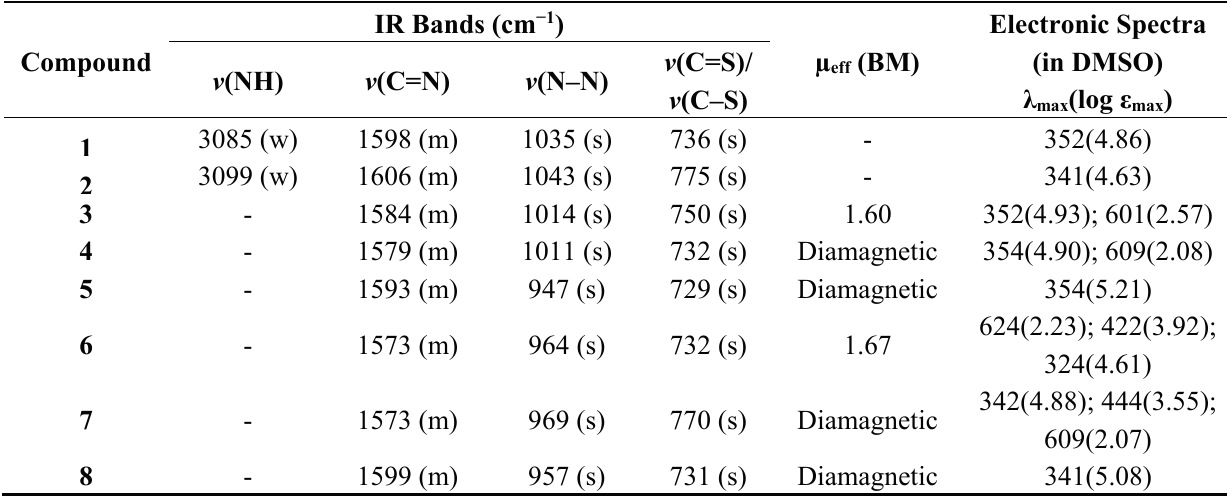
Table 3. Infrared, magnetic susceptibility and electronic spectral data of compounds